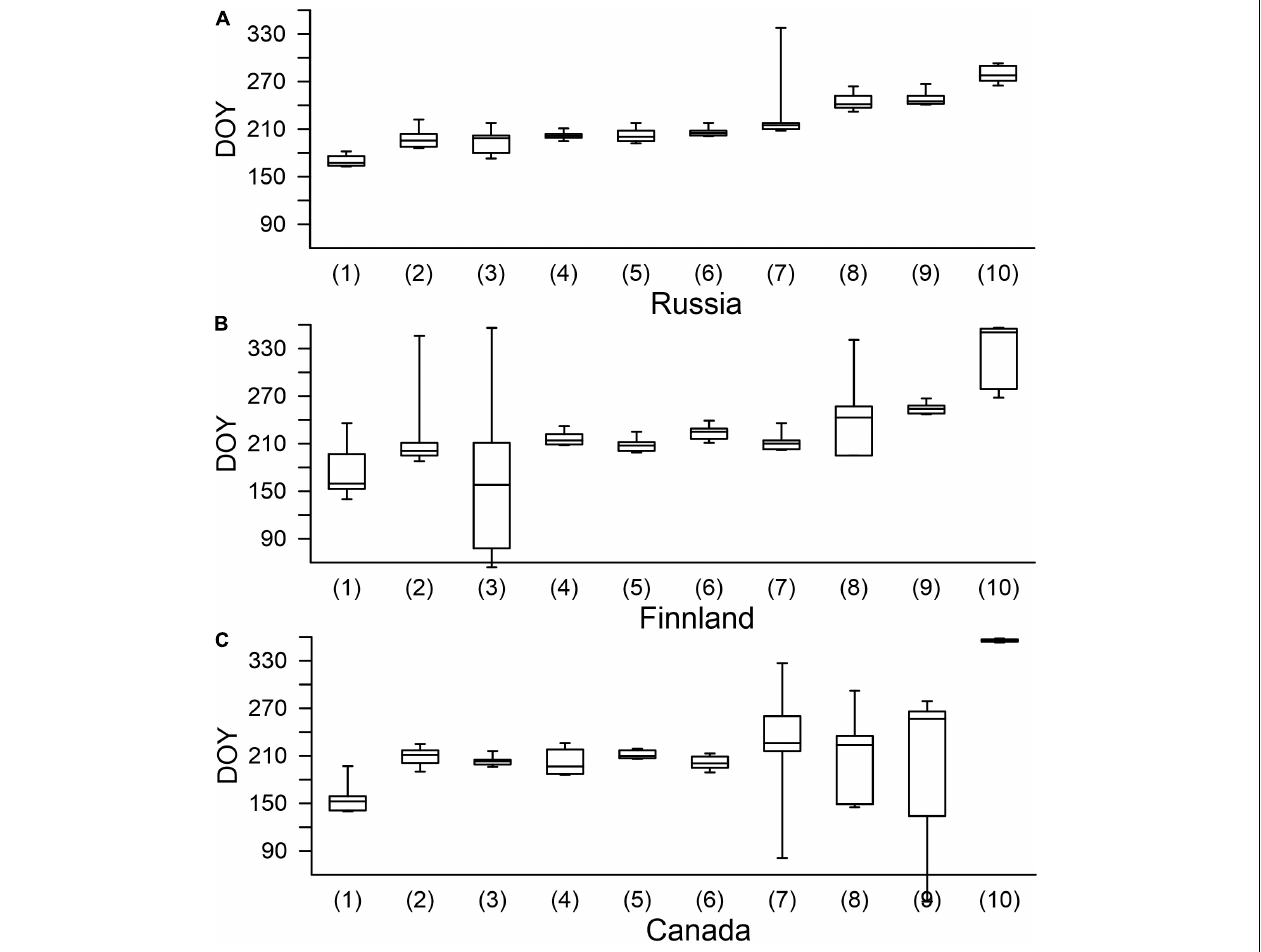
FIGURE 5 | Maximum search volume (RSV) date of 10 examined terms for (A) Russia, (B) Finland, and (C) Canada. Whiskers indicate 10 and 90 percentiles. (1) Honeysuckle, (2) cloudberry, (3) raspberry, (4) currant, (5) (European) blueberry, (6) gooseberry, (7) (bog) bilberry, (8) sea buckthorn, (9) lingonberry, and (10) cranberry is presented in order of increasing RSV date in